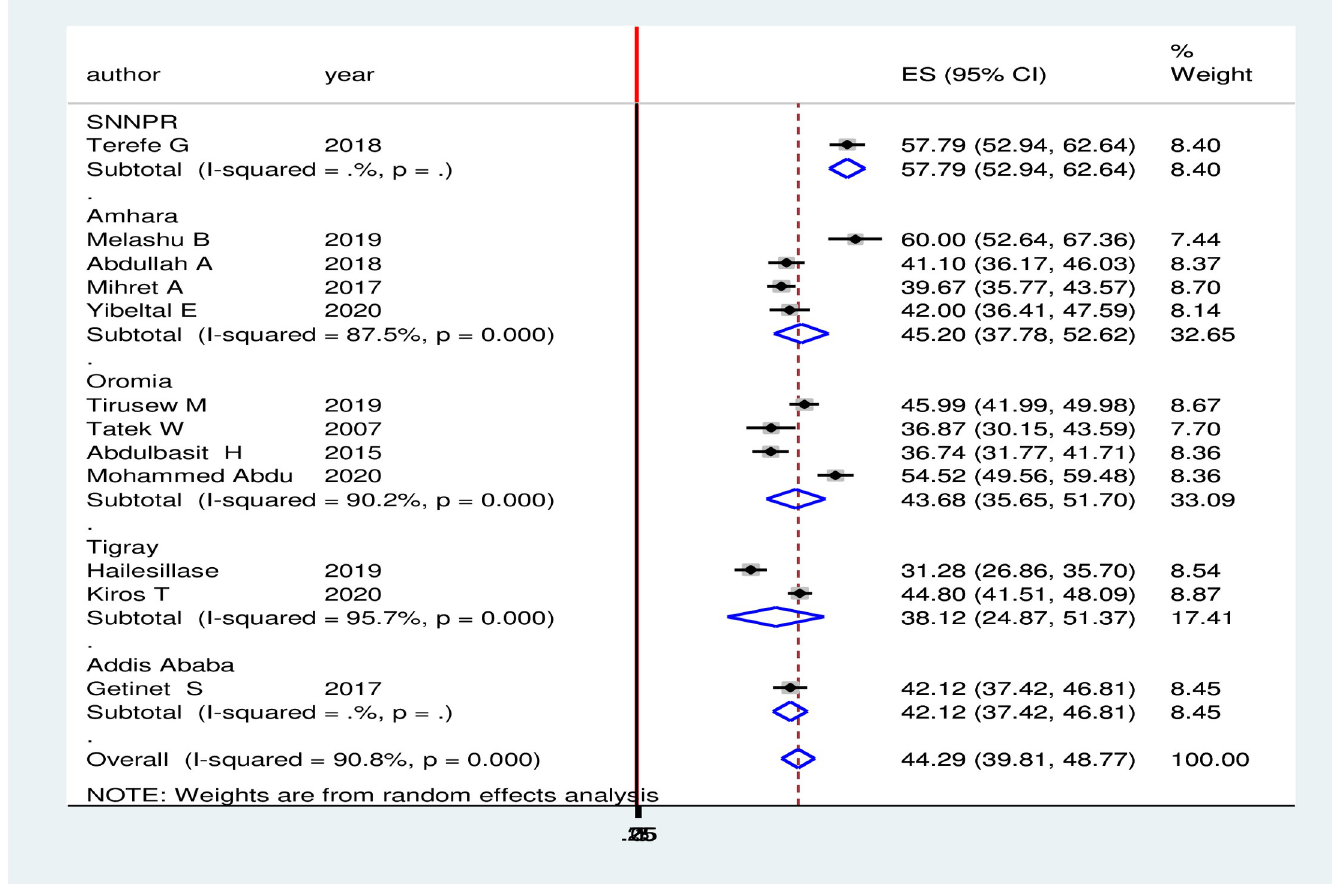
Fig 3. Subgroup analyses by region among TB patient in Ethiopia, 2020.